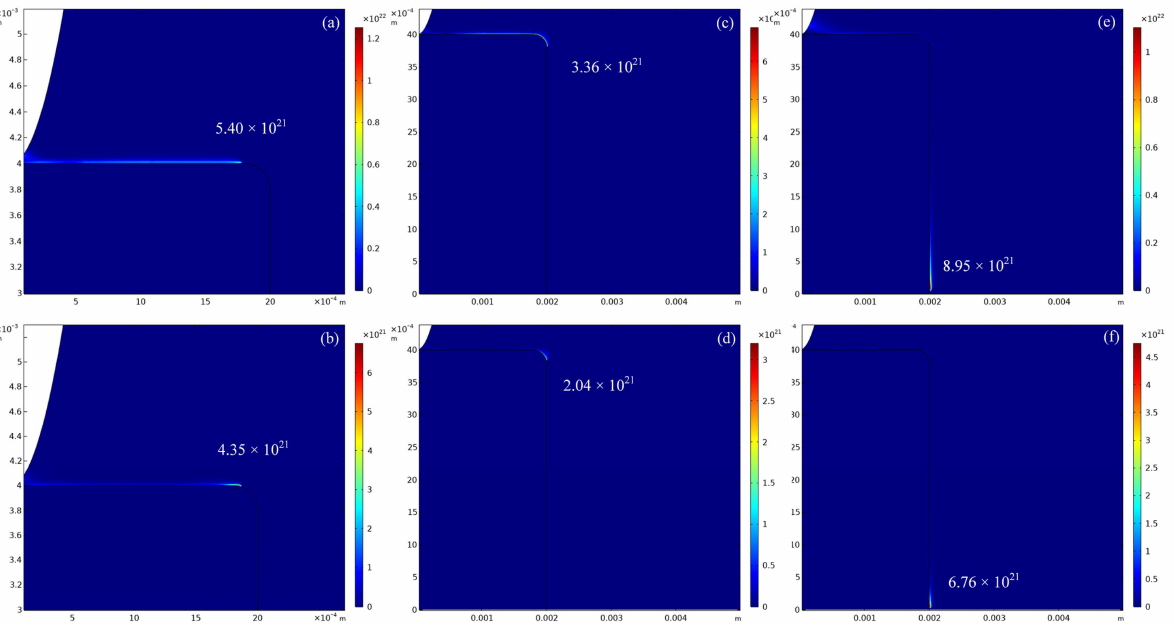
Figure 16. Comparison of electron concentrations for surface discharge in C 4 F 7 N/CO 2 and SF 6 : ( a ) 0.45 ns; ( b ) 0.5 ns; ( c ) 0.7 ns; ( d ) 0.8 ns; ( e ) 2.34 ns; ( f ) 3.42